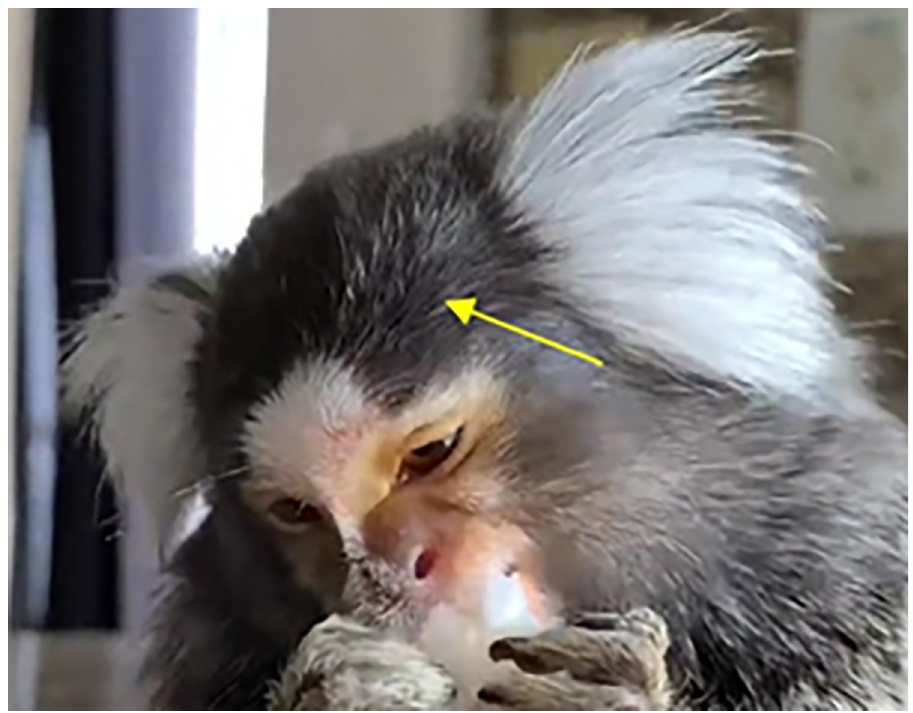
Fig 11. AU109+110—Nose Wrinkler + Upper Lip Raiser. The arrow indicates the direction of movement that is seen when the upper lip is pulled towards the inner eye corner.